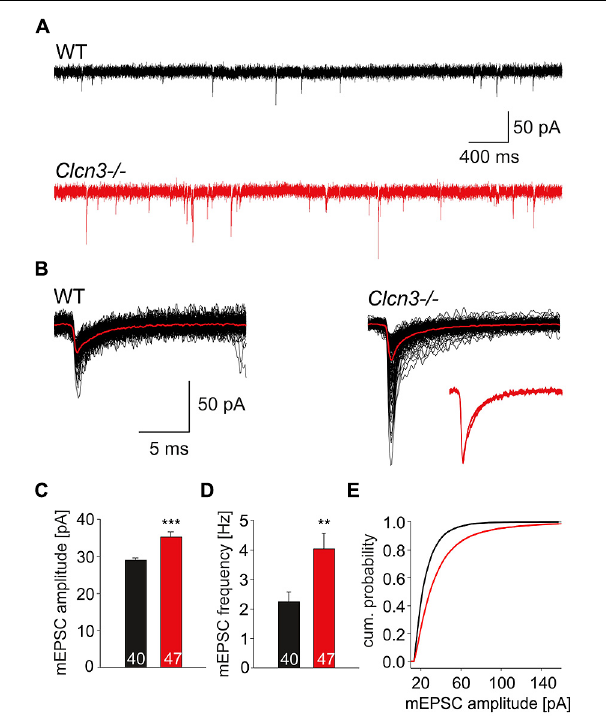
FIGURE 1 | Quantal glutamatergic signals are altered in Clcn3 − / − neurons. (A) Representative mEPSCs fromWT and Clcn3 − / − neurons at a holding potential of − 70 mV. (B) Superimposed representative spontaneous events recorded fromWT or Clcn3 − / − neurons. Averaged quantal events are shown in red, and a comparison of averaged normalized mEPSCs fromWT and Clcn3 − / − neurons are shown as inset. (C) mEPSC peak amplitudes and (D) frequencies from Clcn3 − / − andWT neurons. Data are given as mean ± SEM from at least five different cultures. (E) Cumulative amplitude frequency distribution forWT (black line) and Clcn3 − / − (red line) neurons. (*** p < 0.01 and ** p < 0.001 t -student), numbers in the bars represent the number of evaluated